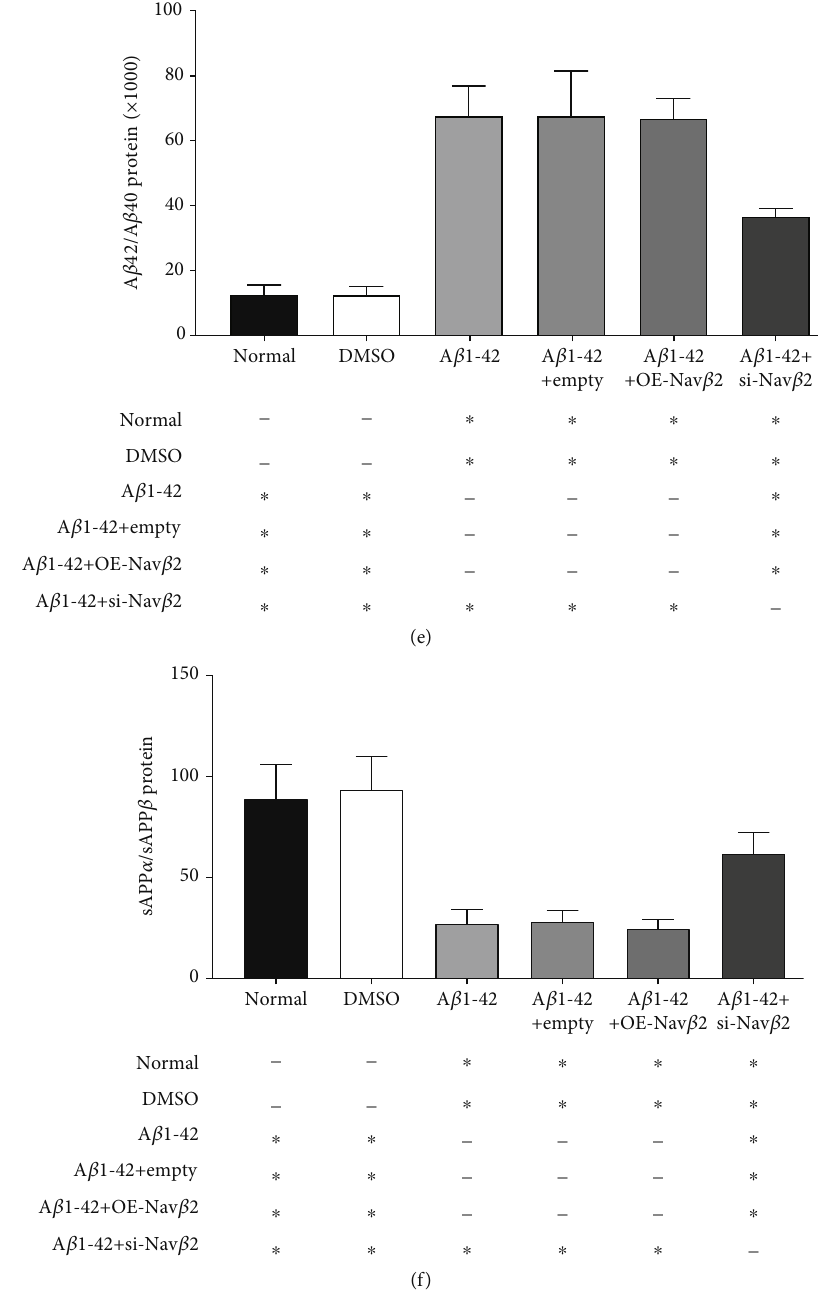
Figure 7: E ff ects of A β 1-42 and Nav β 2 on A β 40, A β 42, sAPP α , and sAPP β in A β 1-42-treated mice. (a – d) Quantitative plots of A β 40, A β 42, sAPP α , and sAPP β in hippocampus of mice from di ff erent groups. (e) The ratio of A β 42 and A β 40 levels from each experimental group. (f) The ratio of sAPP α and sAPP β expression levels from each experimental group. Intragroup sample size n = 7 . ∗ Versus two di ff erent treatment groups, P < 0 : 05 . - Versus two di ff erent treatment groups, P > 0 : 05 . Empty: empty viral vector; OE: overexpression; si: small